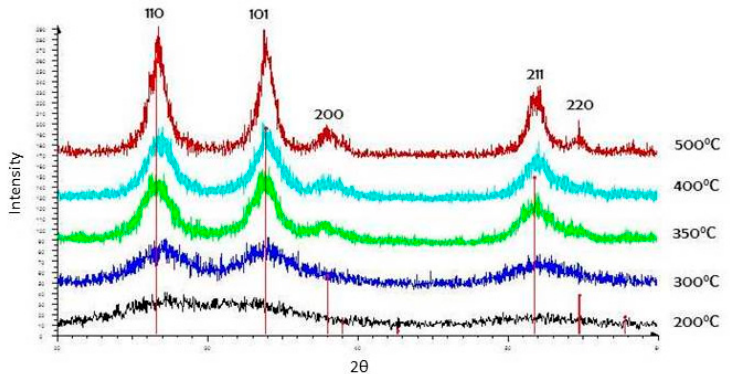
Figure 2. XRD patterns of SnO 2 at different temperatures.